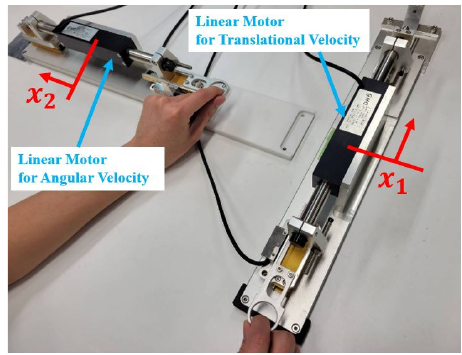
Figure 2. Control